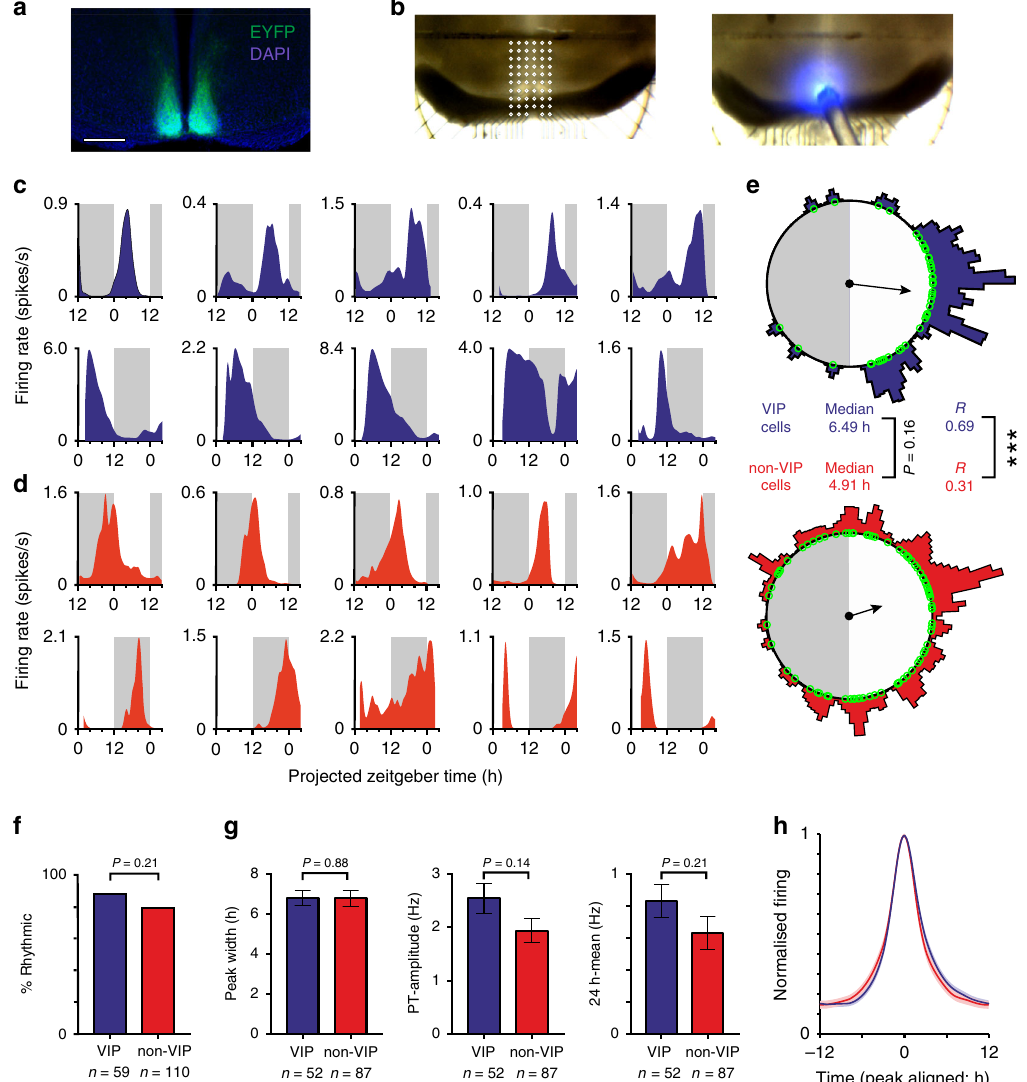
Fig. 1 Suprachiasmatic nucleus VIP neurons provide a coordinated circadian output. a Antibody enhanced EYFP-signal from the SCN of a VIP-ChR2 mouse. Scale bar: 500 µ m. b Light microscope images of a VIP-ChR2 SCN slice in situ on the pMEA; top: overlaid recording site locations, bottom: optical fi bre positioning (460 nm stimulus; 792 mW/m 2 at fi bre tip). c , d Example spontaneous fi ring activity plots for optogenetically identi fi ed VIP ( c ) and non- VIP ( d ) SCN neurons from slices prepared during late (upper panels) or early (lower panels) projected day. e Rayleigh plots showing phase distribution for isolated VIP (blue) and non-VIP (red) SCN neurons that exhibited circadian variation in fi ring ( n = 52 and 87 cells, respectively, from 16 slices). Individual cells are represented by open circles, external histograms represent relative population density (Gaussian smoothing; σ = 10 min). Phase and clustering strength compared by multilevel mixed-effects model (with slice preparation included as a 2 nd level random effect) and Browne – Forsythe ’ s tests, respectively on linearised data (see Methods). f Proportion of isolated VIP and non-VIP SCN neurons displaying evidence of circadian variation in fi ring, compared by Fisher's exact test. g Peak width (full width at half-max fi ring; left), Peak-trough amplitude for fi ring rhythm (middle) and 24 h mean fi ring rate (right) for rhythmic VIP and non-VIP SCN neurons. Data compared by multilevel mixed-effects linear model as above. h Normalised, peak aligned, 24-h fi ring pro fi les of rhythmic VIP and non-VIP neurons, illustrating the very similar circadian waveforms. * P < 0.05, *** P <